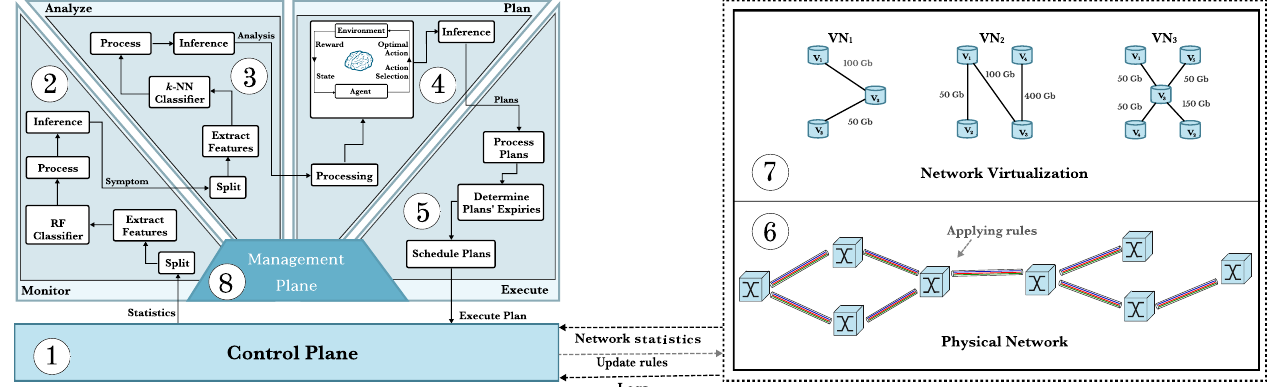
Figure 1. The structure of CO-OP framework in EON-SDM